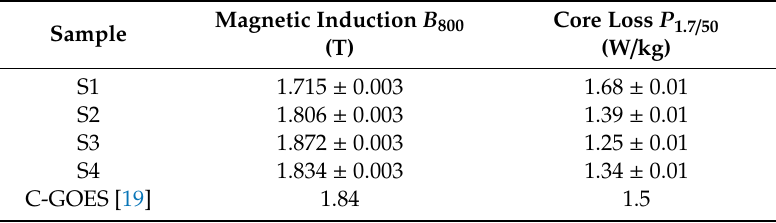
Table 3. Magnetic properties of samples after final